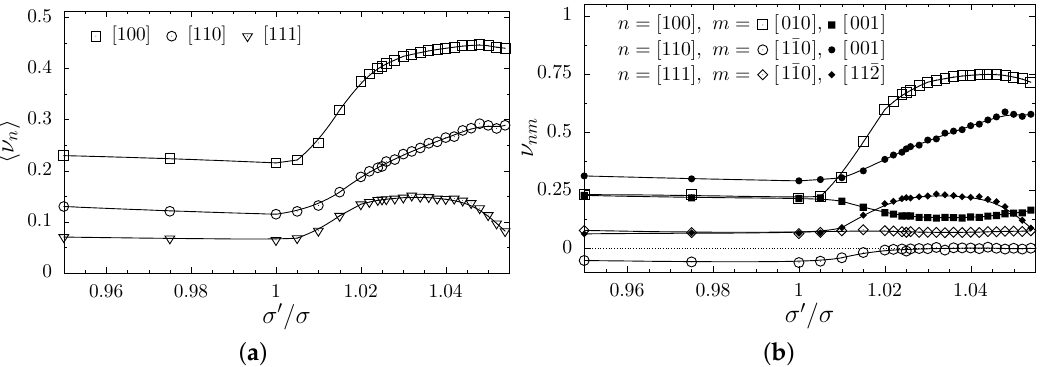
Figure 5. The Poisson’s ratio for systems with ( 001 ) -nanolayers plotted as a function of σ (cid:48) / σ ratio for selected crystallographic directions ( a ) averaged over all (cid:126) m -directions respectively and ( b ) measured in two mutually orthogonal (cid:126) m -directions (marked pairwise with open or filled symbols). The lines are drawn to guide the